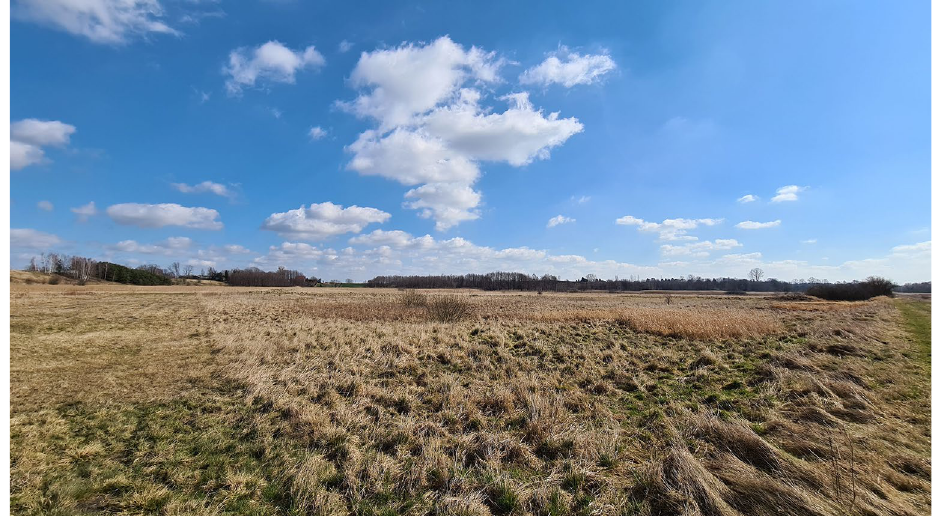
Figure 4. Meadow with the established research plot. Photo by Z.